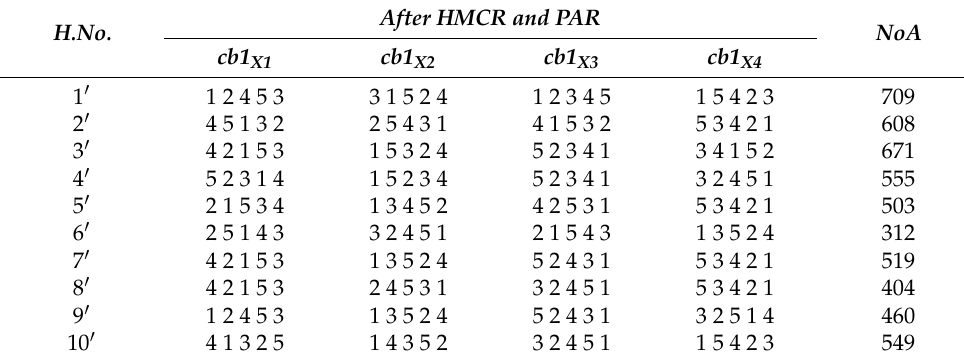
Table 12. Harmony after HMCR and PAR .